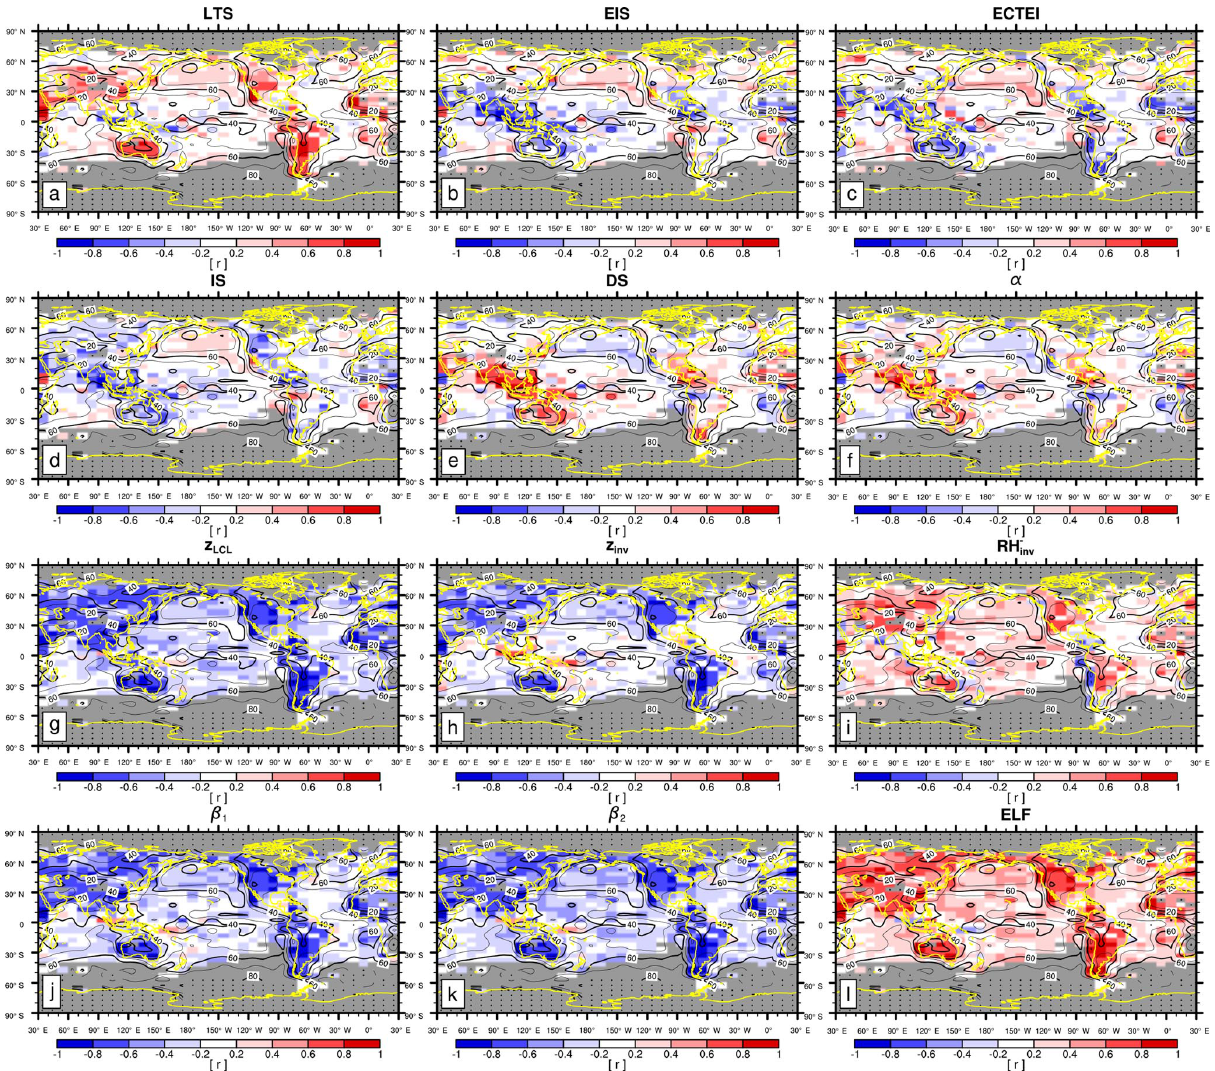
Figure 10. The same as Fig. 9 but for interannual variation only without the seasonal cycle. This plot was generated by using the four-seasons data (DJF, MAM, JJA, SON) in each year with the seasonal climatology subtracted in each season, such that only interannual variation is included in this correlation